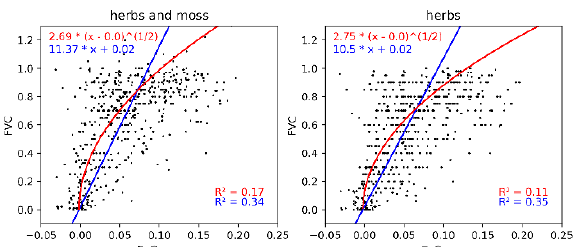
Figure 5. Relationship between ExG (10.08.2021) and FVC (measured field data). Fitted functions are indicated in red (square root-function) and blue (linear model).